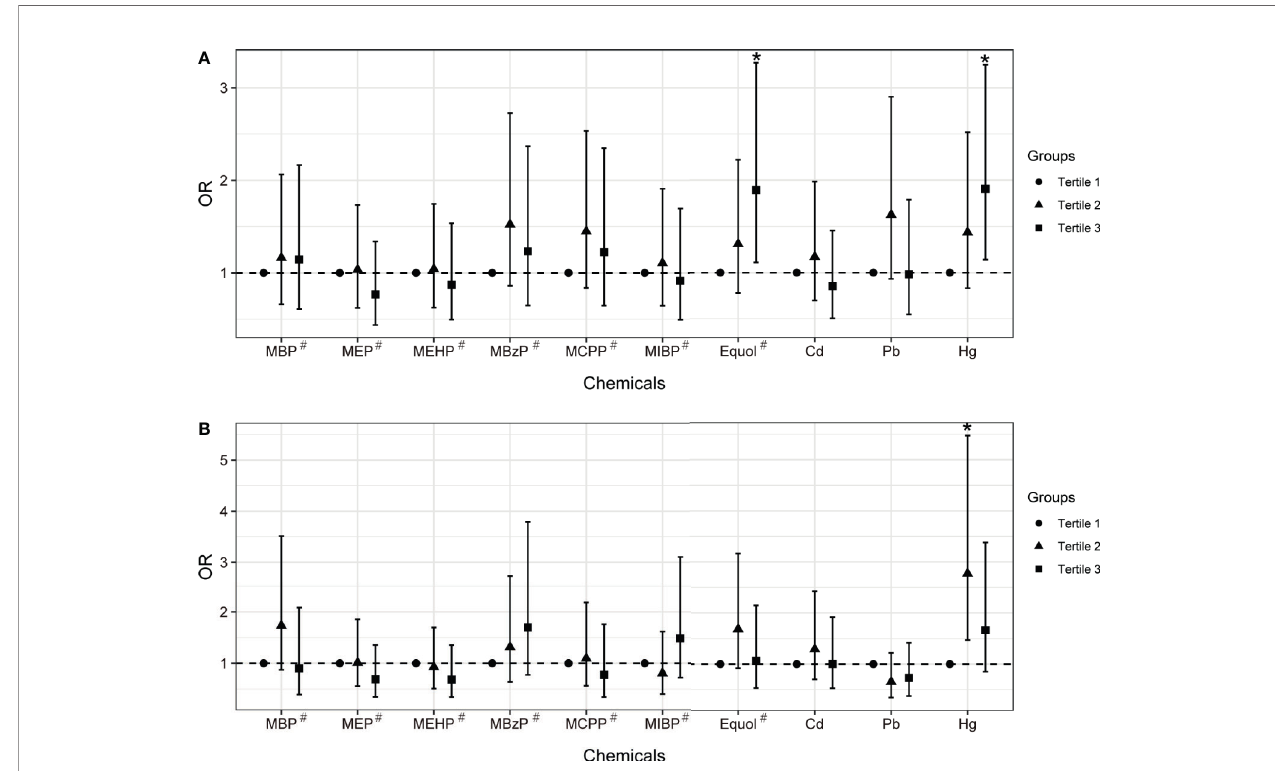
FIGURE 1 | The associations between chemical exposure and uterine leiomyomata (A) or endometriosis (B) in women aged between 20 and 54 years old with multivariable logistic regression model. Models were adjusted for age, ethnicity, BMI group, ovary removal, female hormone usage, pregnant status, and menopause status. Models # were further adjusted for log-transformed urinary creatinine levels. *Indicates P-value < 0.05.